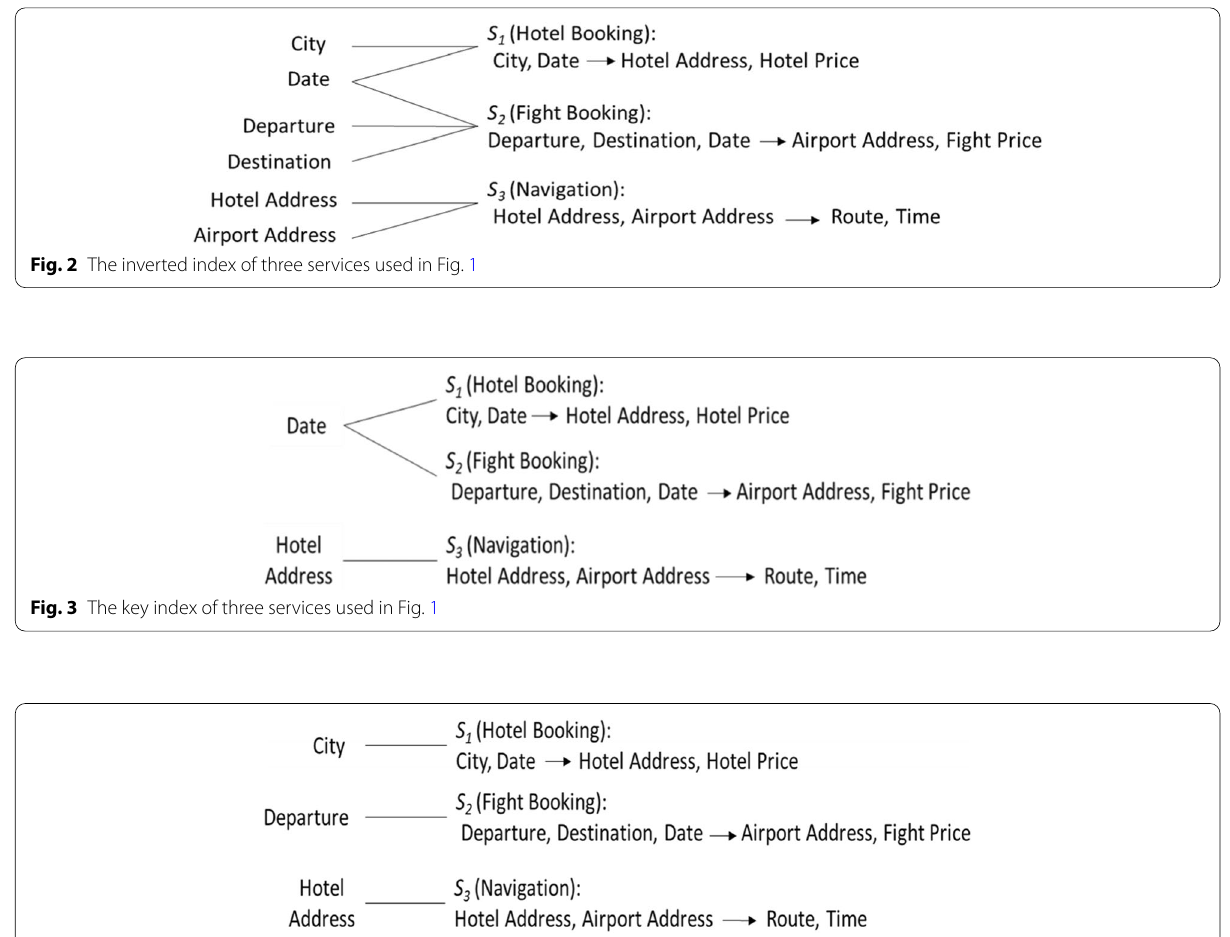
Fig. 4 A different key index of three service used in Fig. 1, which is used to illustrate that the key selection affects retrieval